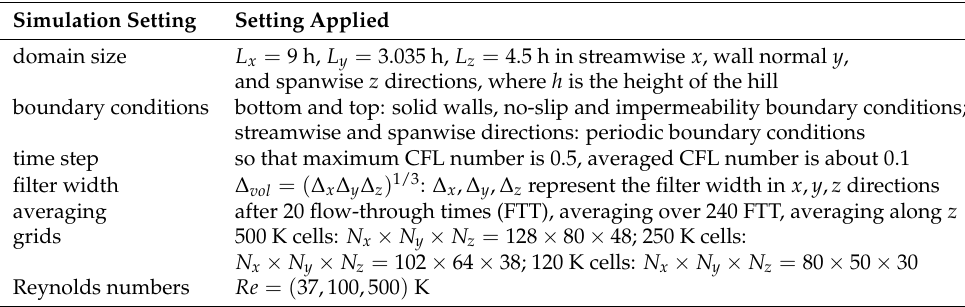
Table 2. Periodic hill flow simulation set-up data.